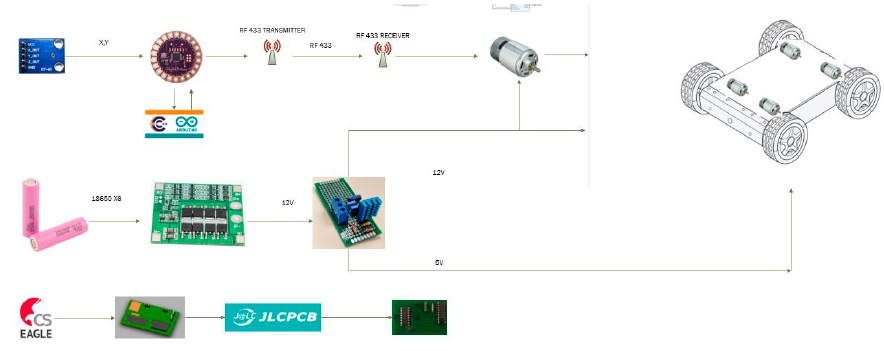
Figure 4. Robotic chassis subsystem .